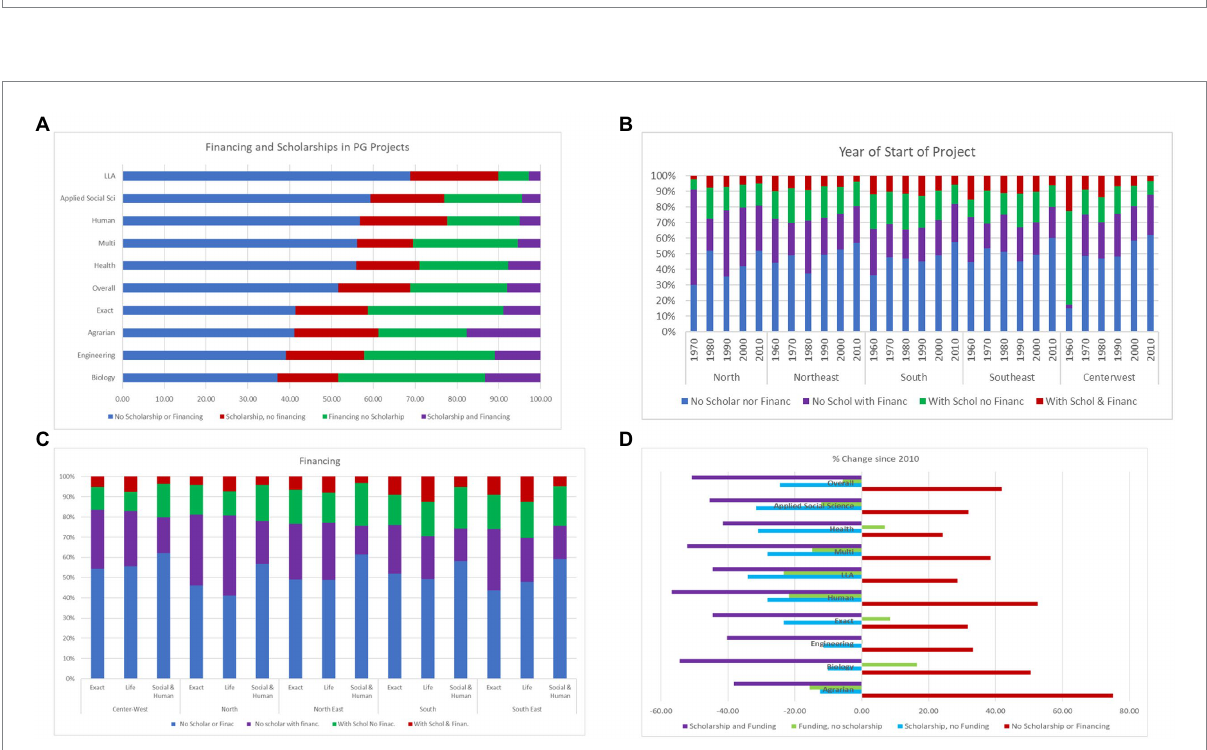
FIGURE 7 Financing of post-graduate projects in 2020 (A) area of knowledge, (B) decade of start of project, (C) region and (D) % change since